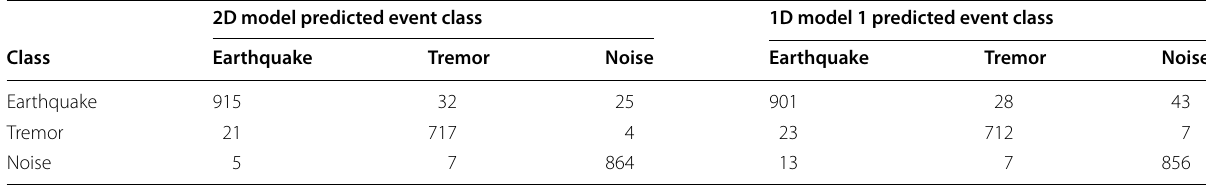
Table 2 Confusion matrices for 2D CNN and 1D CNN model 1 to the Nankai trough dataset 2D model predicted event